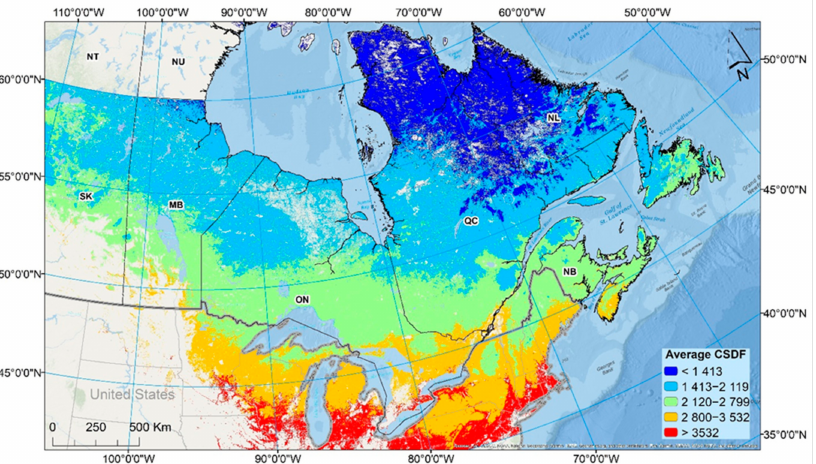
Figure 5. Cumulative average annual surface degree days >0 ◦ C of forest habitats (CASDD) in Central and Eastern Canada from 2000 to 2015.